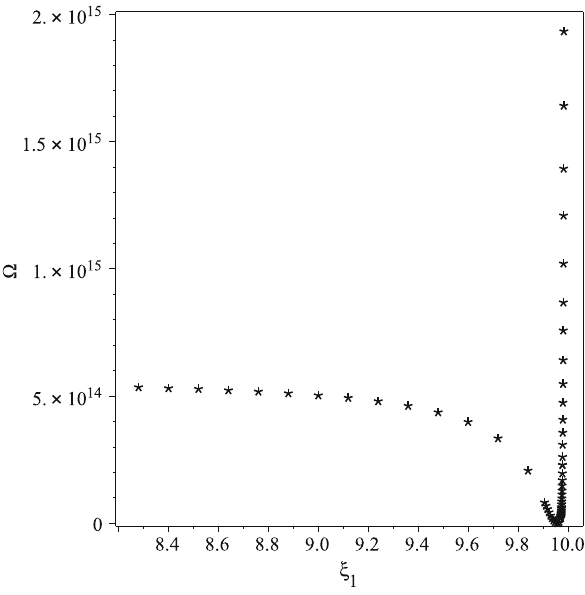
Fig. 7 Auxiliary function (cid:5) vs. the minimization parameter ξ 1 for ξ ∗ = 9 . 57 ,ξ ∗ = 1 . 85 and f ( R ) -parameters a = − 2 , b = 1 , c = 2 3 − 0 . 02. The minimum of (cid:5) corresponds to ξ ∗ = 1 . 85 ) = 5 . 3 × 10 9 . 96 ,ξ ∗ 3